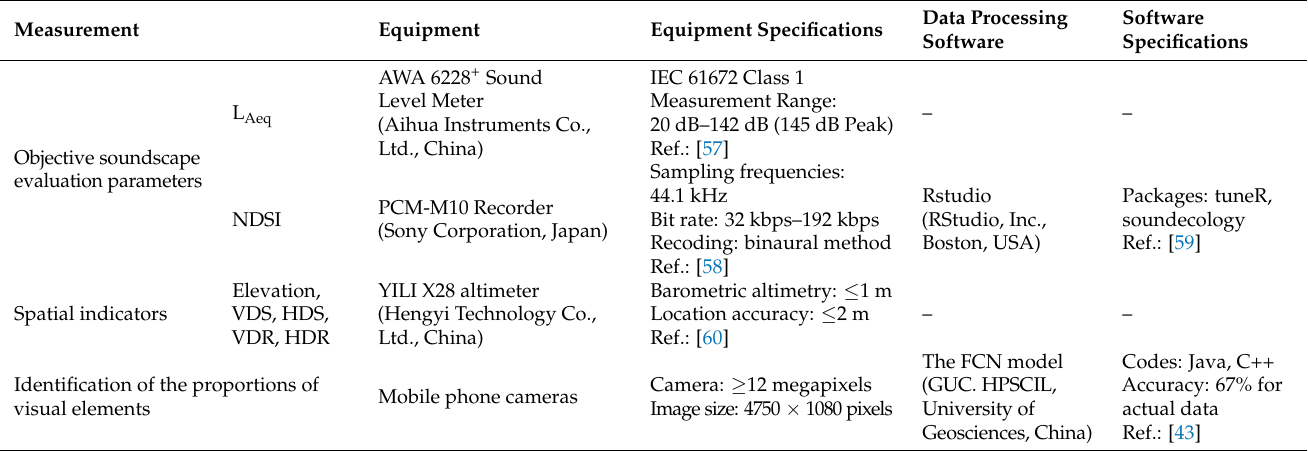
Table A2. Detailed specifications of all measurement equipment and associated data processing software in the